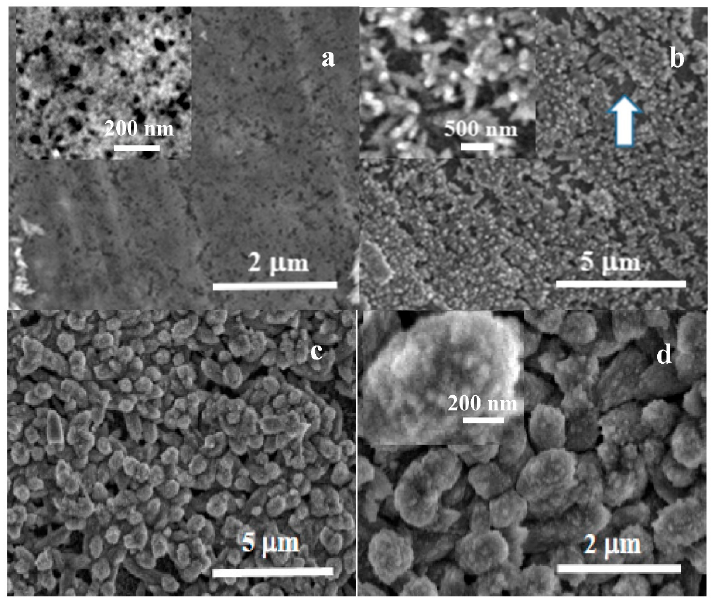
Figure 6. SEM micrographs showing the evolution with carbonatation time of Mg disks after ( a ) 5 min, ( b ) 15 min, and ( c , d ) 30 min immersion times.